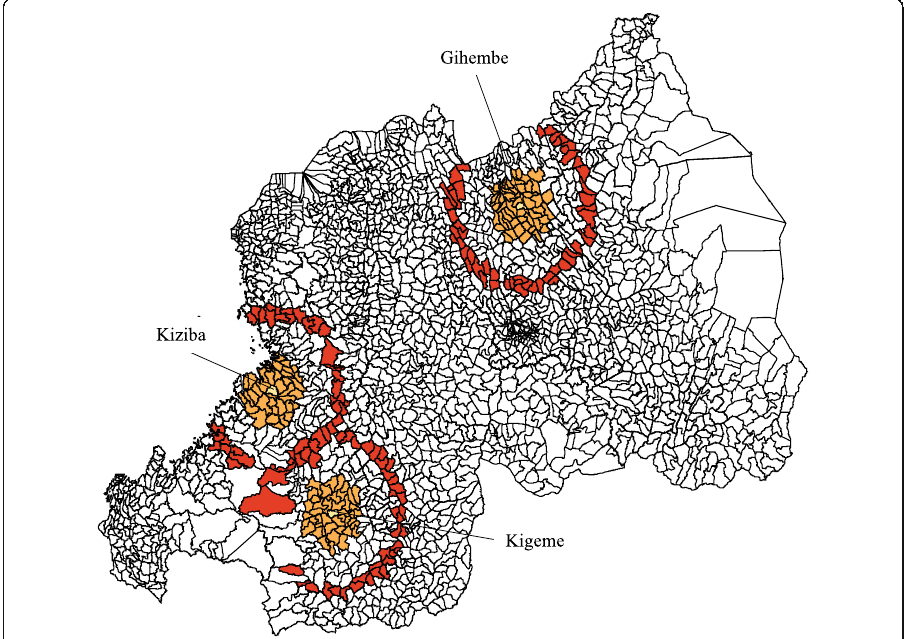
Fig. 1 Sampling strategy at the cell level. Note: Own generation based on publicly available administrative GIS data. Yellow cells indicate the location of each refugee camp. Orange cells are those within 10 km of each camp. Red cells are those above 20 km of each